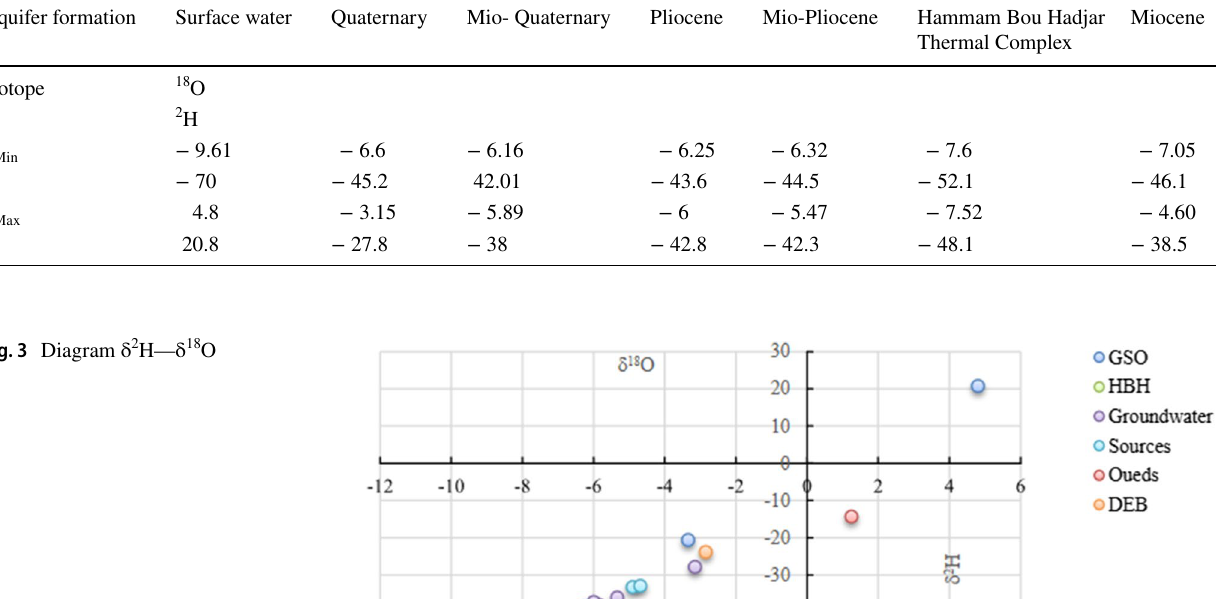
Table 3 Range of grades (‰ vs SMOW) Aquifer formation